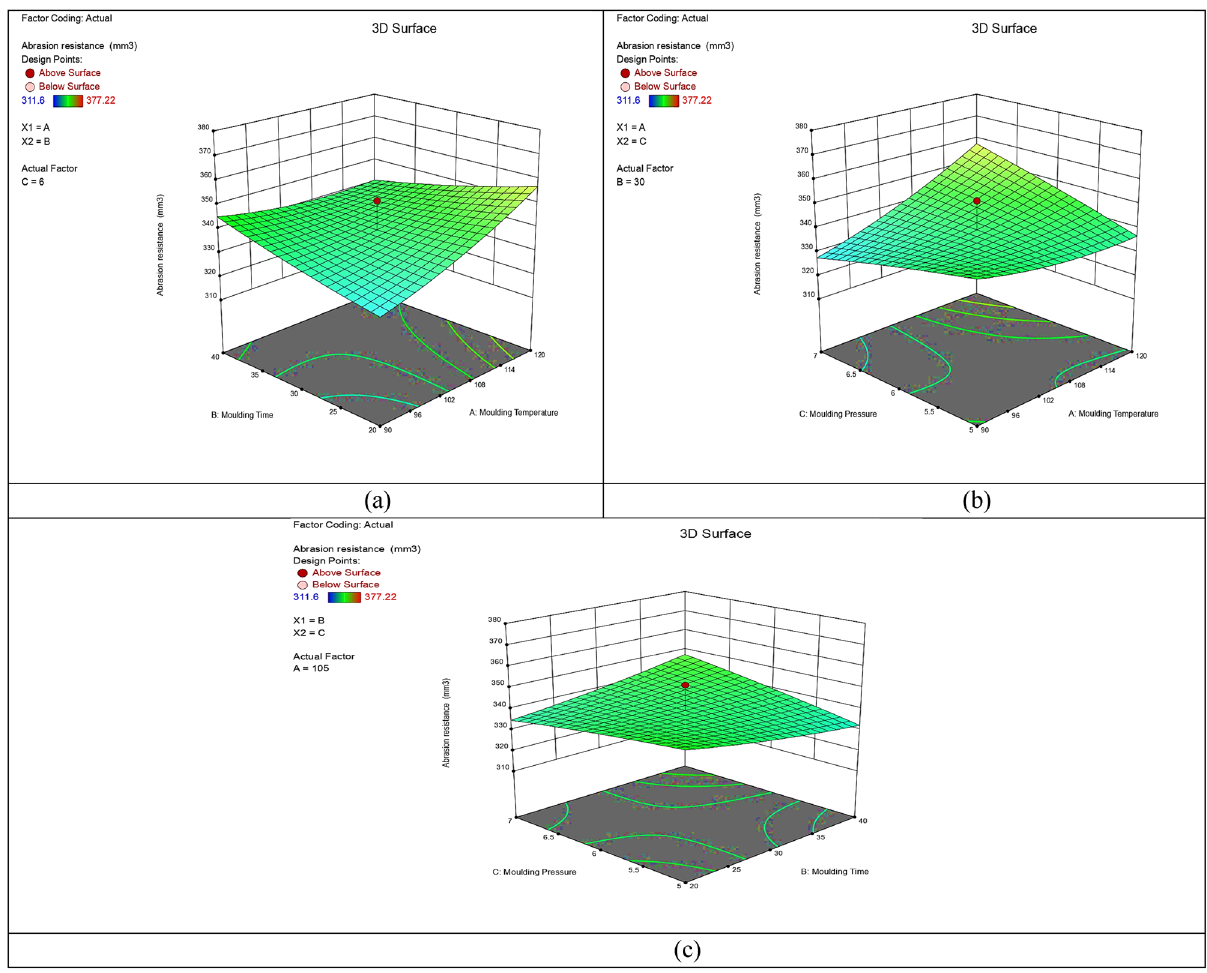
Figure 25: ( a – c ) 3D interaction plots for abrasion resistance of leather bu ffi ng dust reinforced recycled EVA polymer composites.